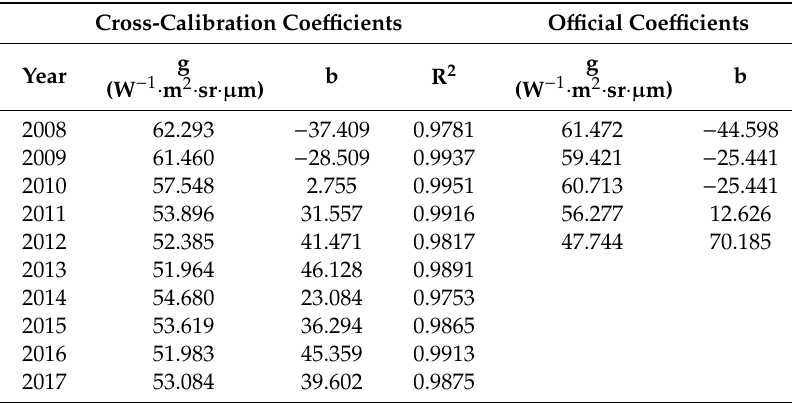
Table 3. Table 3. Radiometric calibration coe ffi cients of IRS B08 from 2008 to 2017.